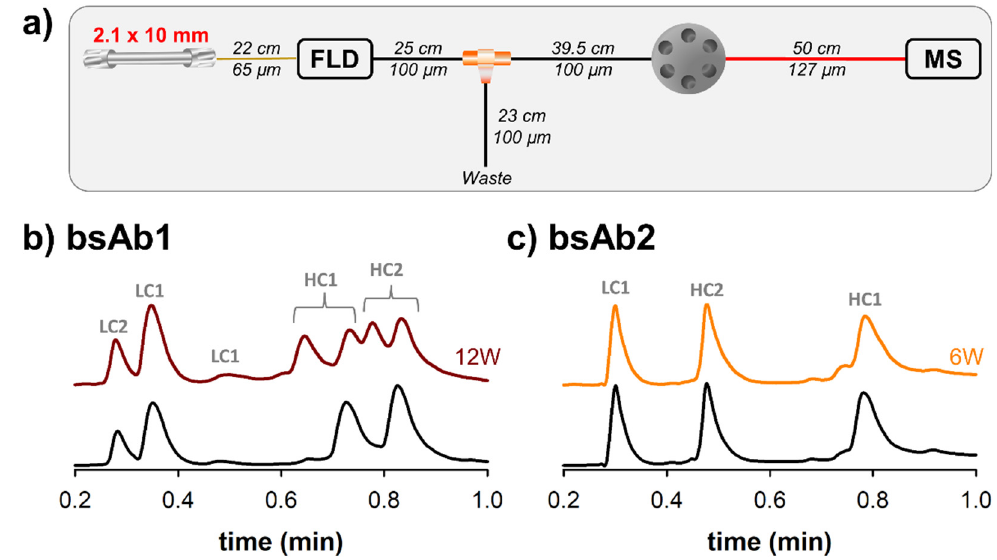
Figure 4. RPLC-Fluorescence-MS analysis of bsAbs. ( a ) Schematic representation of the instrument configuration reporting the length and the internal diameter of the tubing used to realize the liquid chromatography-Fluorescence-Mass Spectrometer (LC-FLD-MS) flow path and the flow splitting. Total ion chromatograms (TICs) of the different bispecific antibodies (bsAbs), namely bsAb1 ( b ) and bsAb2 ( c ) acquired before (black) and after thermal stress performed at 40 °C for 6 (orange) or 12 (brown) weeks. HC and LC stand for heavy chain and light chain, respectively.